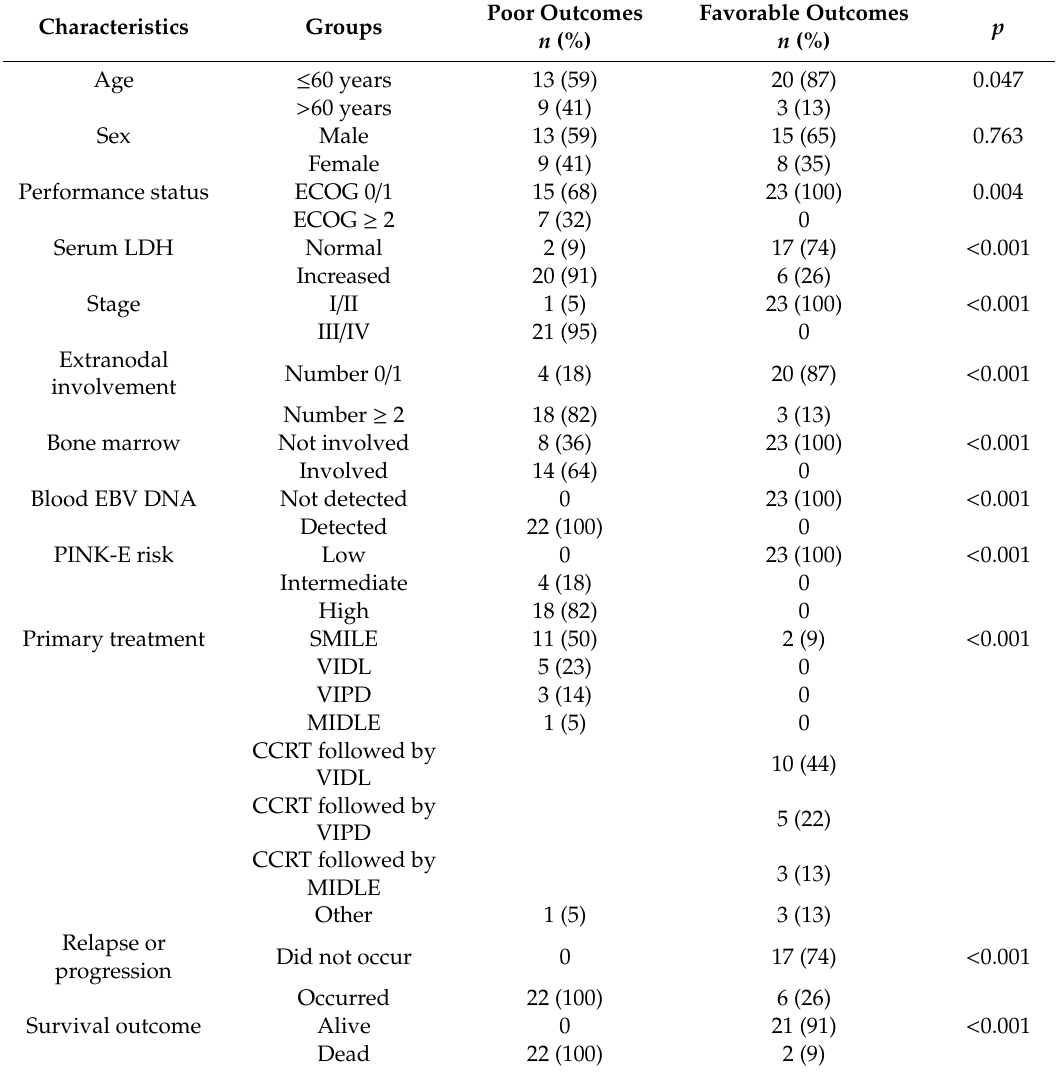
Table 1. Characteristics of patients in the training